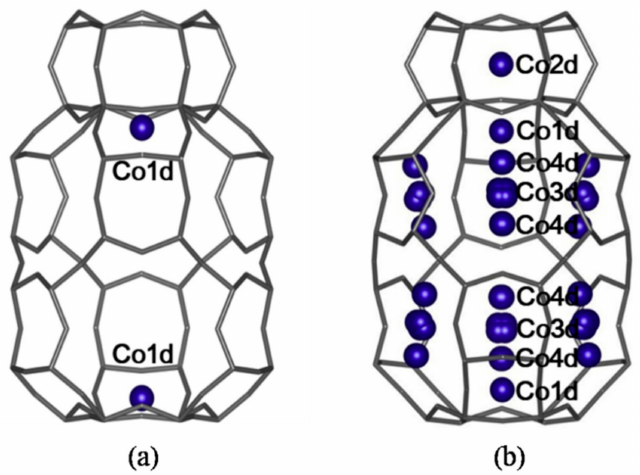
Figure 4. Structure of cobalt ion in zeolite: ( a ) Co-CHA-6.0-0.39/Co-CHA-10-0.46/Co-CHA-16-0.47 ( b ) Co-CHA-2.4-0.40. Color code: Si and O, grey; Co, blue.